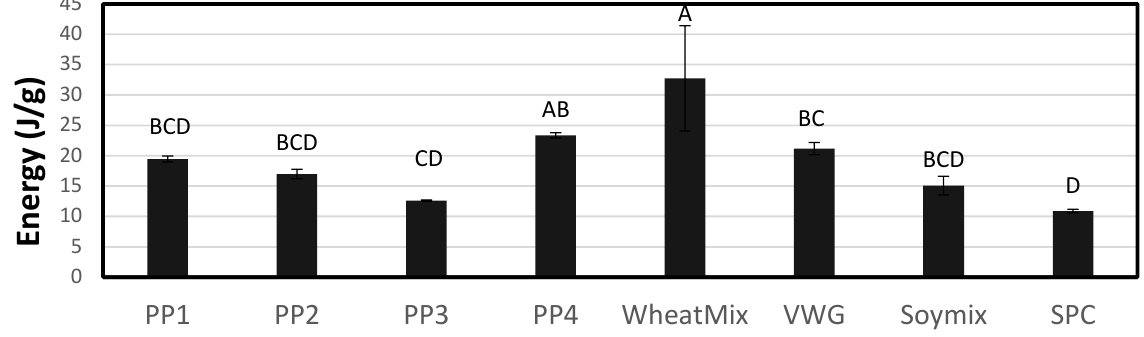
Figure 7. Mean energy required to denature proteins in the raw material as determined by DSC. Bars denoted by the same letter are not significantly different ( p < 0.05).